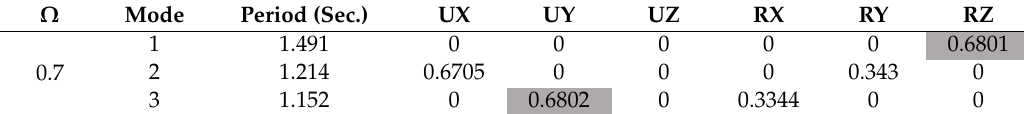
Table 7. Modal Participating Mass Ratio Buildings (with b / r = 3.16, 1 < Ty < 2 s, Ω = 0.7).